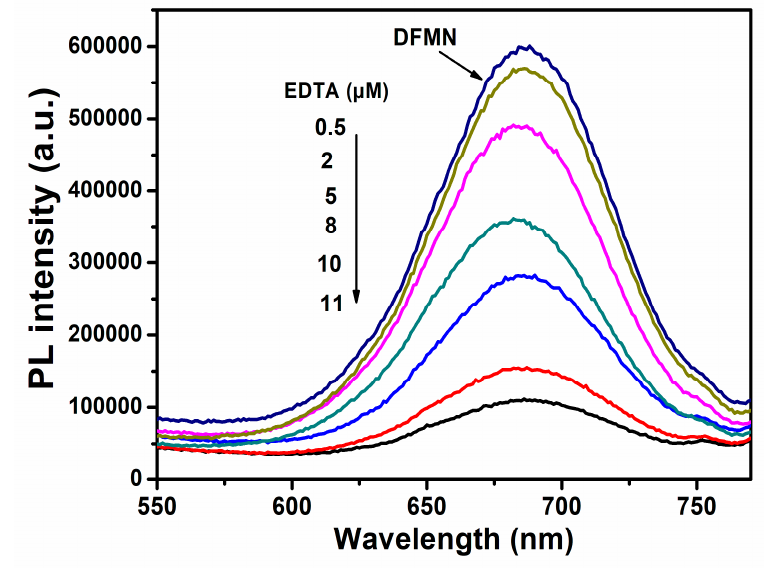
Figure 5. Fluorescence spectra of DMFN under di ff erent concentrations of EDTA.